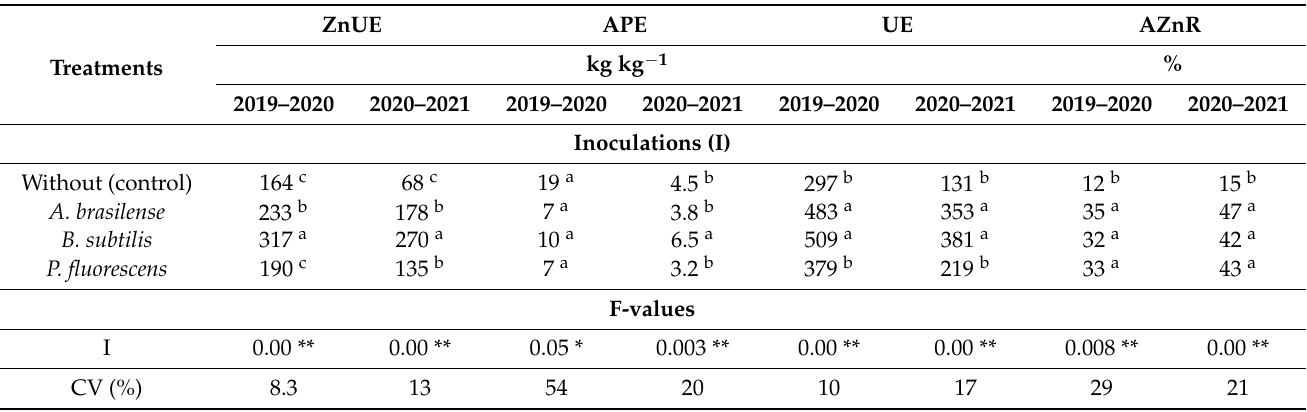
Table 4. Zinc efficiencies of maize as function of residual zinc fertilization and diazotrophic